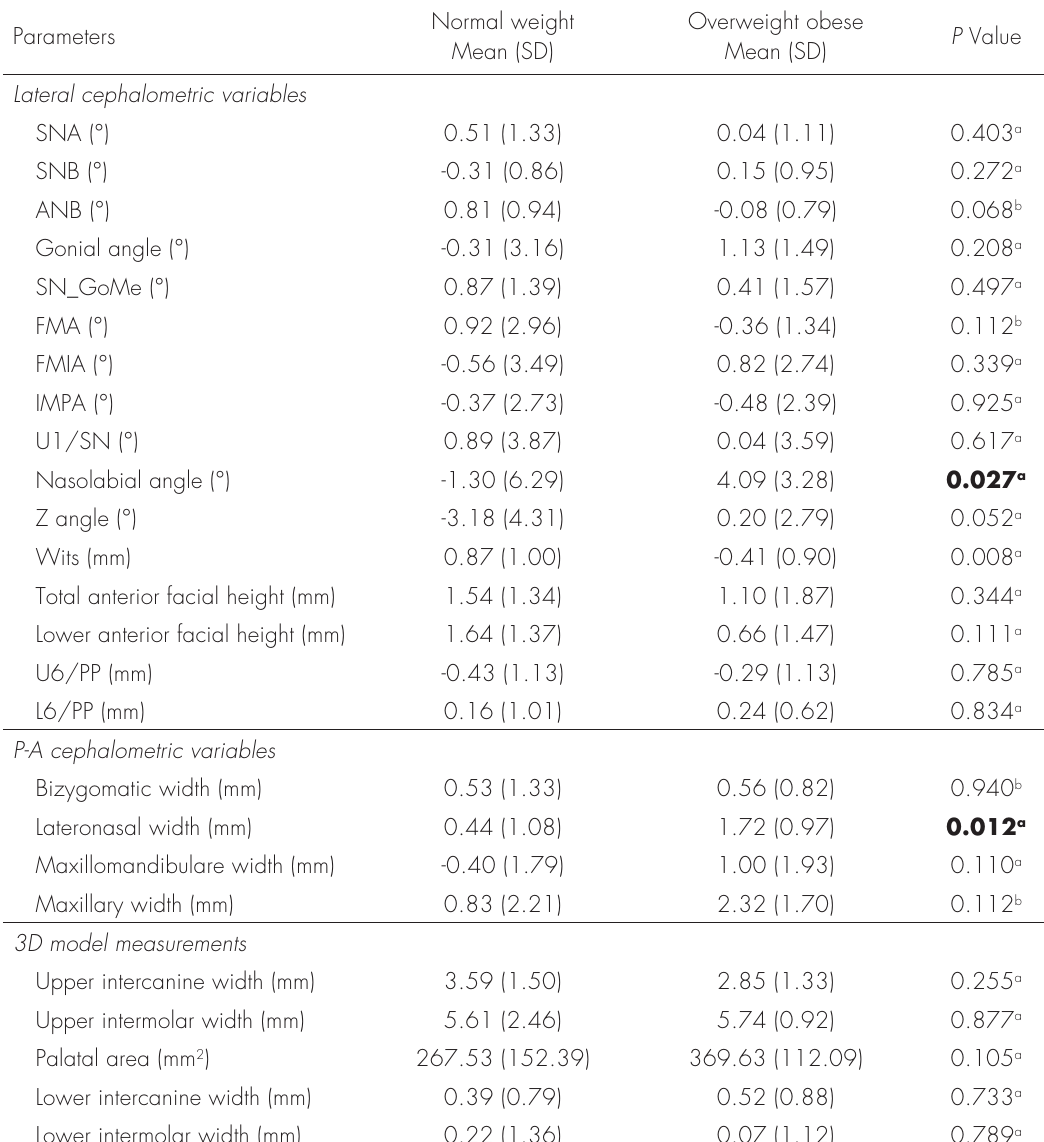
Table III. Comparison of evaluated parameter changes (T1–T0) between groups.